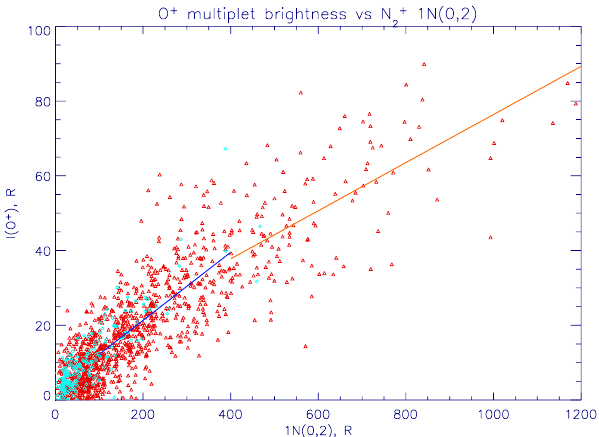
Fig. 9. Plots of O1 vs. O3 (cyan diamonds), and O2 vs. O3 (orange triangles) in electron aurora. Solid lines show linear fits to the